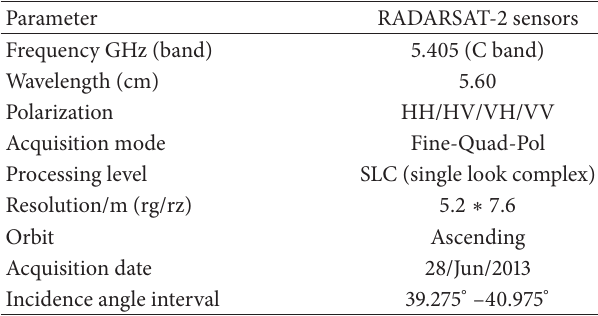
Table 1: Characteristics of the SAR images in the study acquired by RADARSAT-2